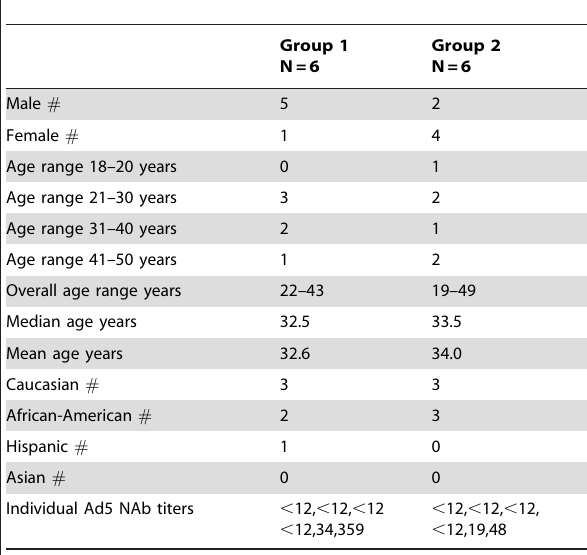
Table 4. Demograpic characteristics of volunteers enrolled in Group 1 and Group